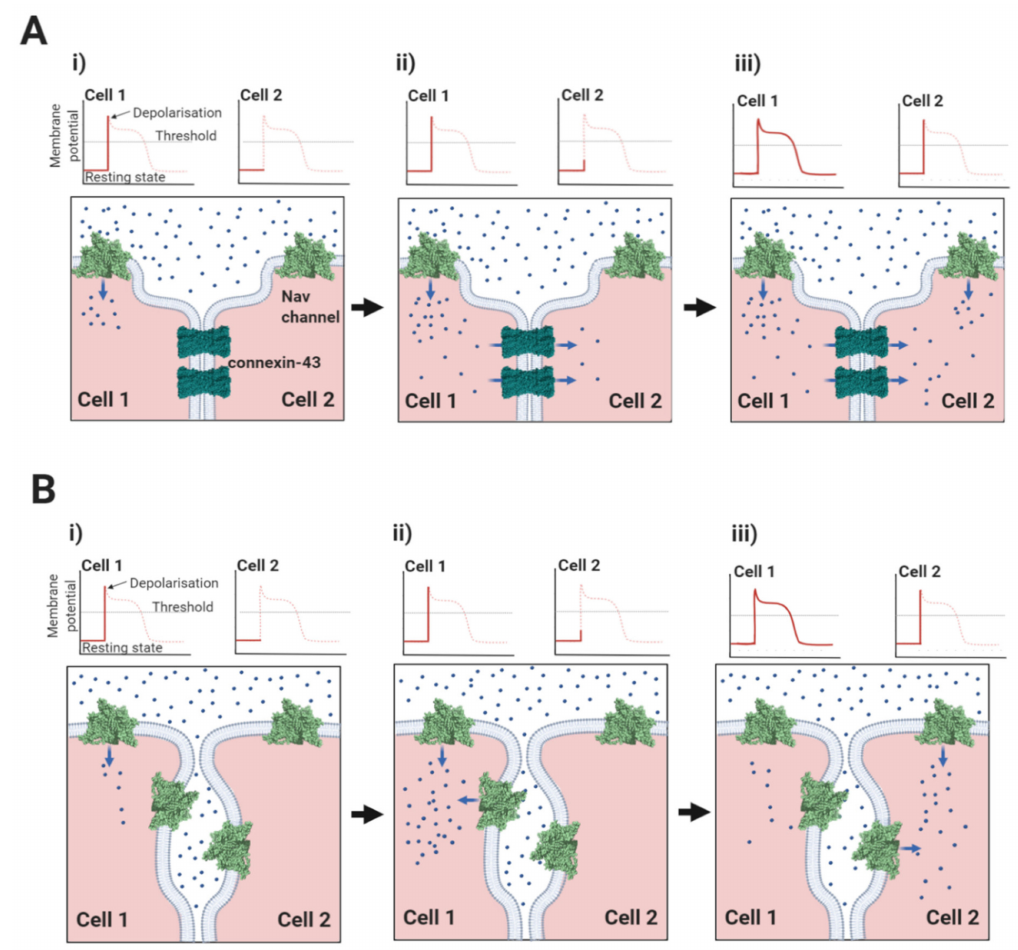
Figure 5. Comparison of electrotonic and ephaptic conduction mechanisms. ( Ai ); In electrotonic conduction, depolarisation of cell 1 by an action potential generates a membrane potential across the gap junction comprising connexin molecules. ( Aii ); The resulting current flow from active cell 1 to quiescent cell 2 causes its membrane to depolarise. ( Aiii ); When this changing membrane potential rises above the threshold for Nav channel opening, an action potential is initiated in cell 2 and the excitation wave is propagated. Note, the involvement of direct charge transfer between successive cells in this process, which involves an ohmic transfer of charge. ( Bi ); In ephaptic conduction, Nav channel excitation depolarises cell 1. ( Bii ); As a result, Nav channels in the perinexal membrane of cell 1 become depolarised and there is a removal of sodium ions (and hence a net removal of positive charge) from the ephaptic space separating cells 1 and 2. ( Biii ); The negative change in electrostatic potential within the restricted ephaptic space is enough to depolarise the transmembrane potential in cell 2, causing the activation of its Nav channels and propagation of the excitation wave. Note the absence of direct charge transfer between successive cells in this process, which involves an electrostatic transfer of charge. For clarity, only connexin-43 gap junction channels and Nav channels are shown, and in the action potential profiles, the Nav channel threshold has been displaced